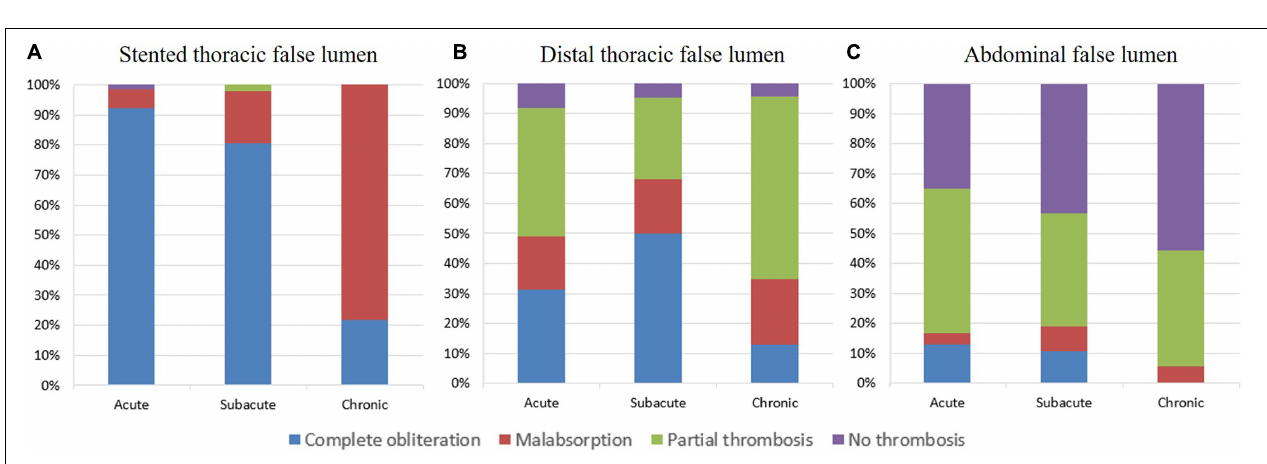
FIGURE 5 | The degree of FL thrombosis in the last follow-up. The complete obliteration, malabsorption, partial thrombosis, or no thrombosis status of FL at the stented thoracic aorta (A) , distal thoracic aorta (B) , and abdominal aorta (C) observed in acute, subacute, and chronic TBADs in the last follow-up.